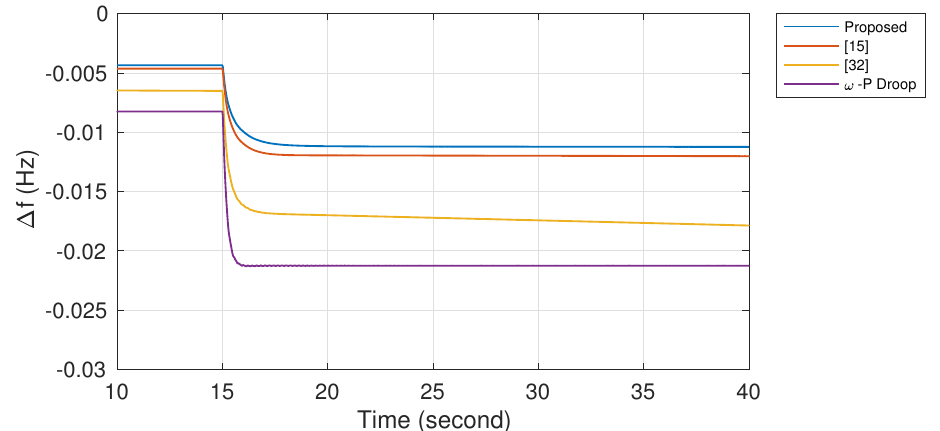
Figure 11. Comparison of the frequency deviation of the proposed control system with existing control